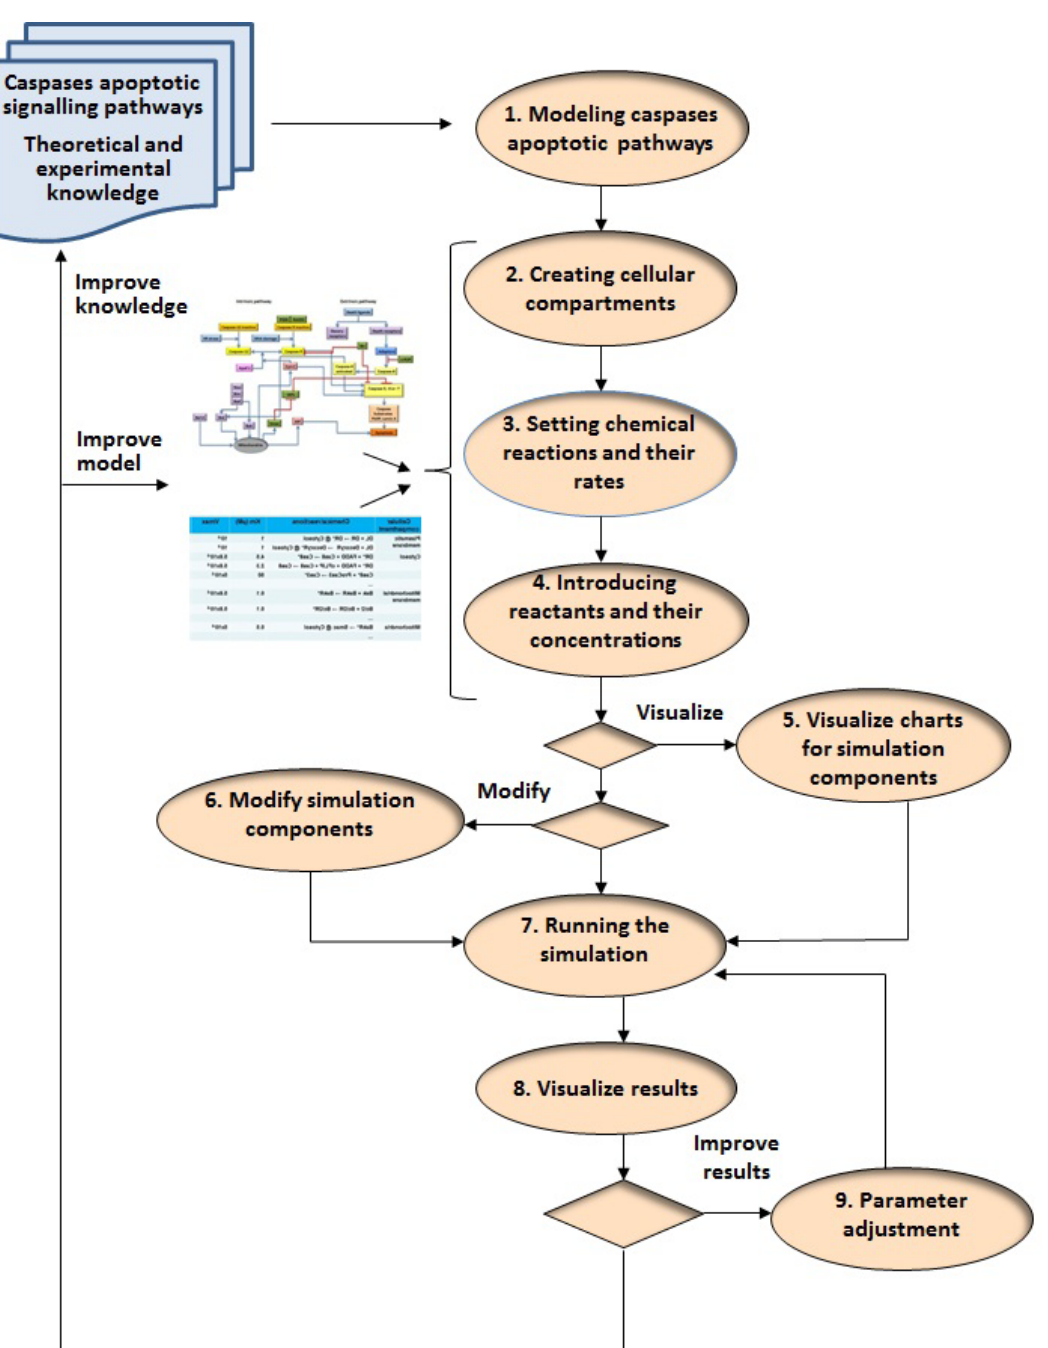
Figure 2: Methodological framework for modelling and simulation of caspases apoptotic signalling